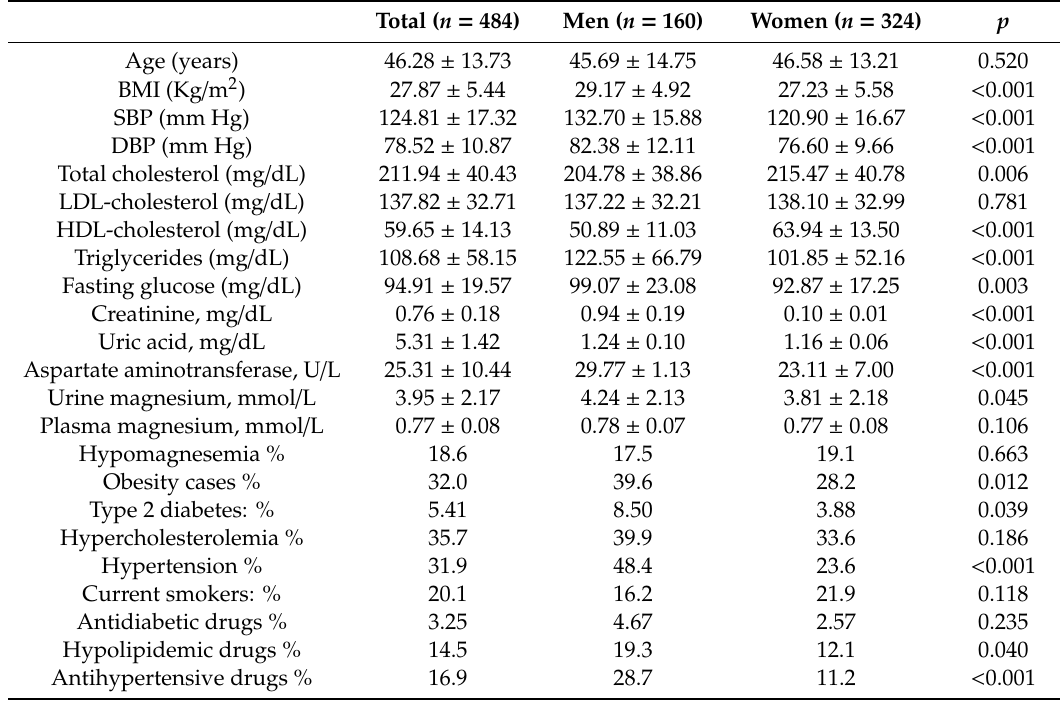
Values are mean ± SE for continuous variables and % for categorical variables. BMI indicates body mass index; SBP indicates systolic blood pressure, DBP indicates diastolic blood pressure; p : p -value for the comparisons (means or